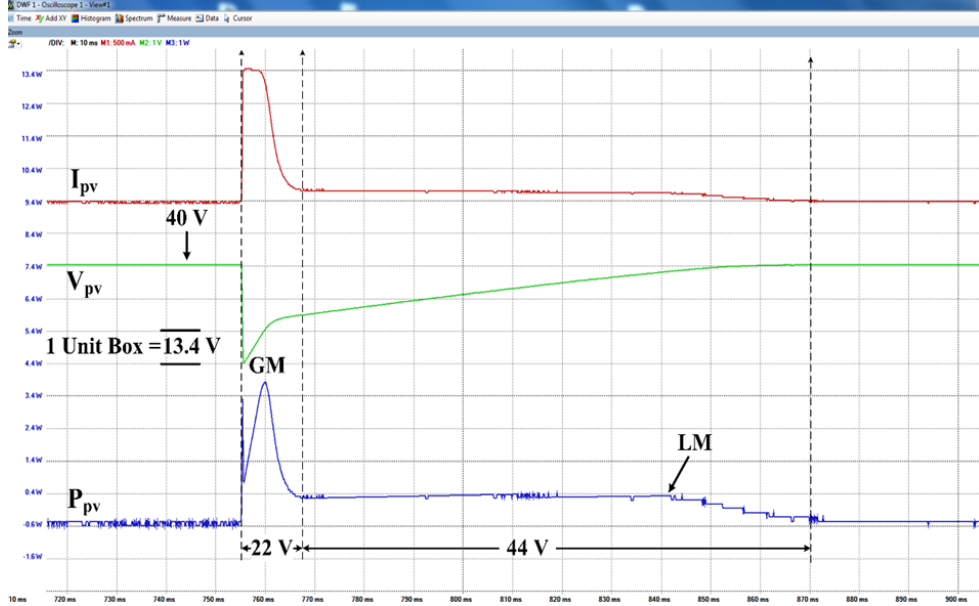
Figure 8. I-V and P-V under partial shading in case 1.